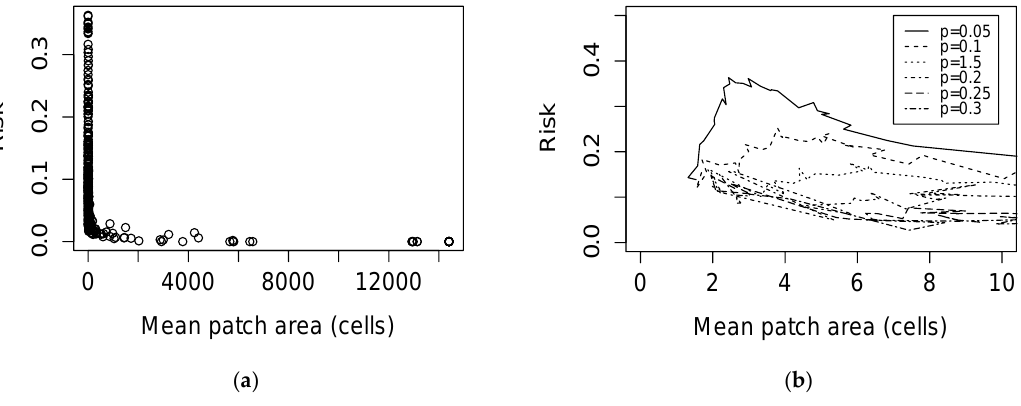
Figure 5. Predicted Lyme disease risk as a function of mean patch area. ( a ) LDI as a function of patch area across all simulated landscapes; ( b ) LDI as a function of area stratified by percolation probability p , with axes rescaled to better show maxima. Each curve connects landscape scores evaluated at sequential values of habitat occupancy A (0.1–0.9).